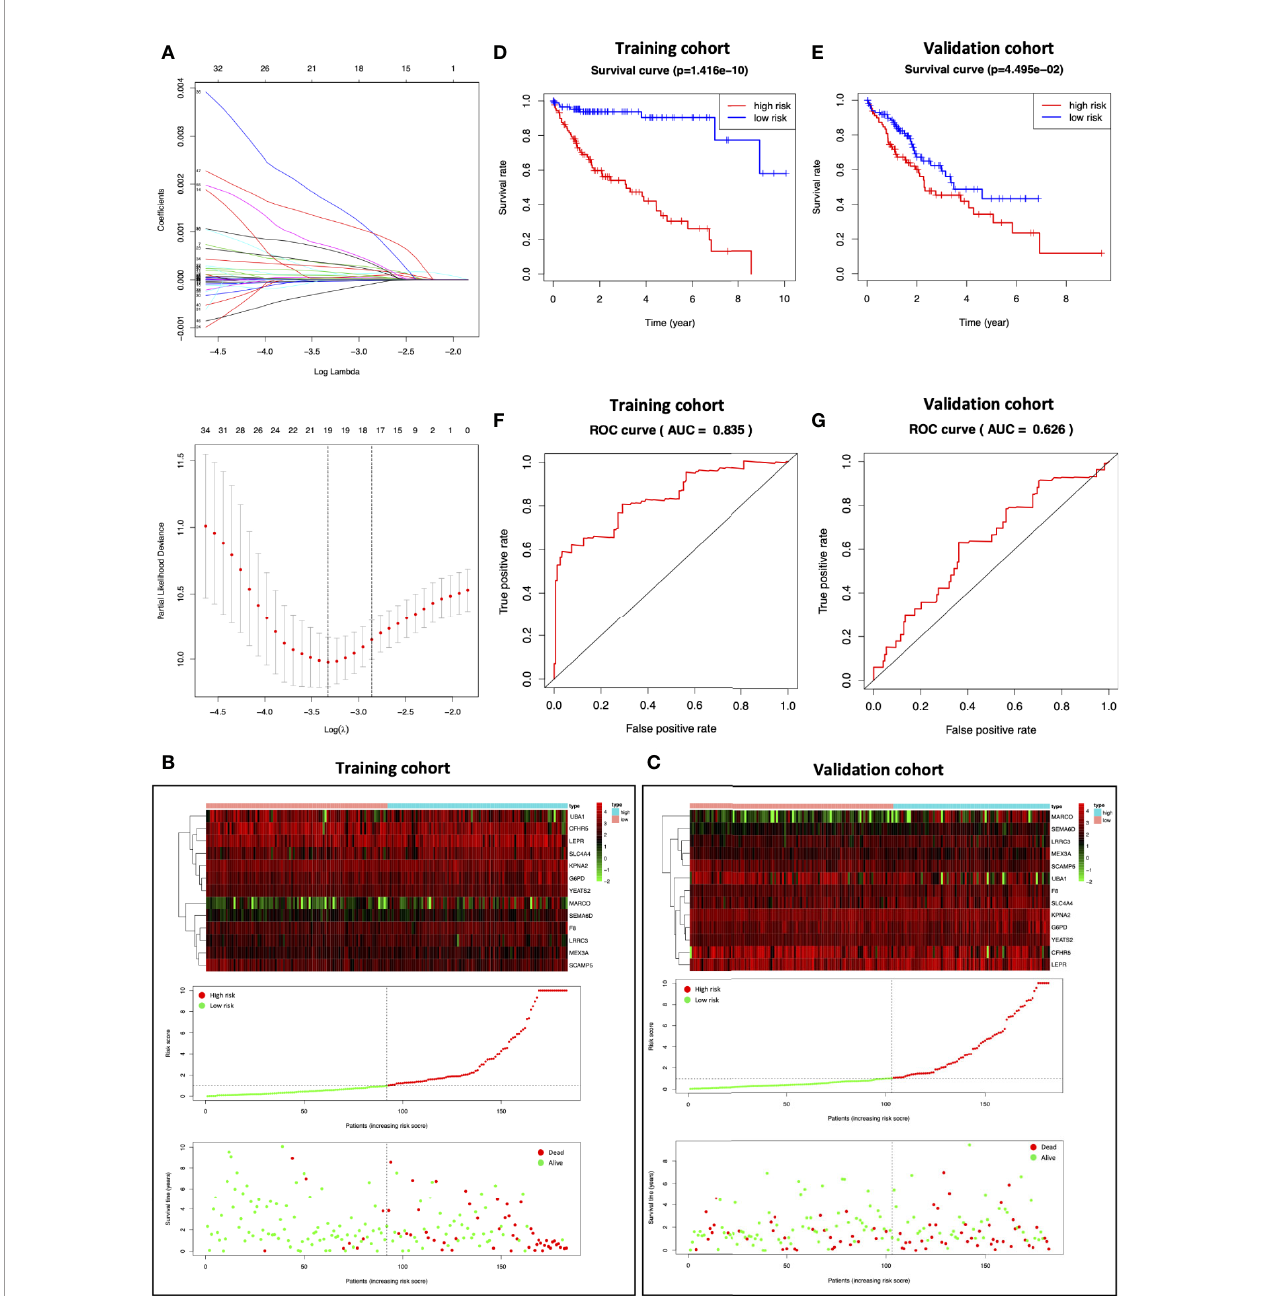
FIGURE 5 | Construction of the prognostic model. (A) Determination of the number of factors by LASSO analysis. (B, C) The top represents the expression pattern of the prognostic signature genes in the classi fi ers of the high- and low-risk groups; the center represents the distribution of the risk score; the bottom represents the survival status of patients in the training and validation cohorts. (D, E) Kaplan – Meier survival curves of the training and validation cohorts. (F, G) ROC curve for the training and validation